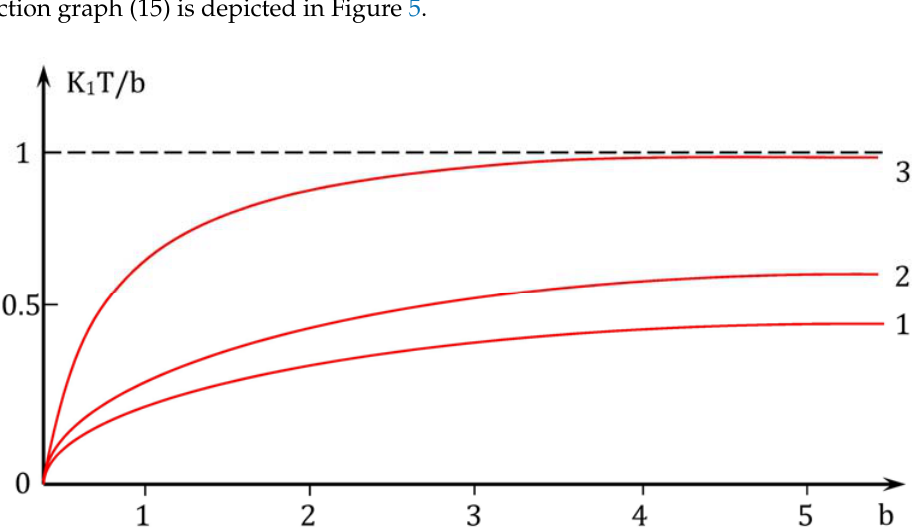
Figure 5. Dimensionless relationship for T and b at various values of K 1 / K 2 . 1: K 1 / K 2 = 10, 2: K 1 / K 2 = 1, 3: K 1 /K 2 = 0.1